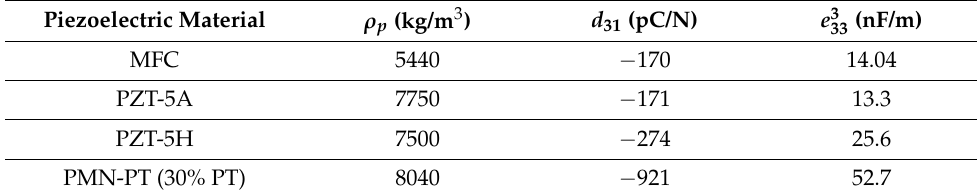
Table 3. Densities and Piezoelectric Properties of Different Piezoelectric Materials. Piezoelectric